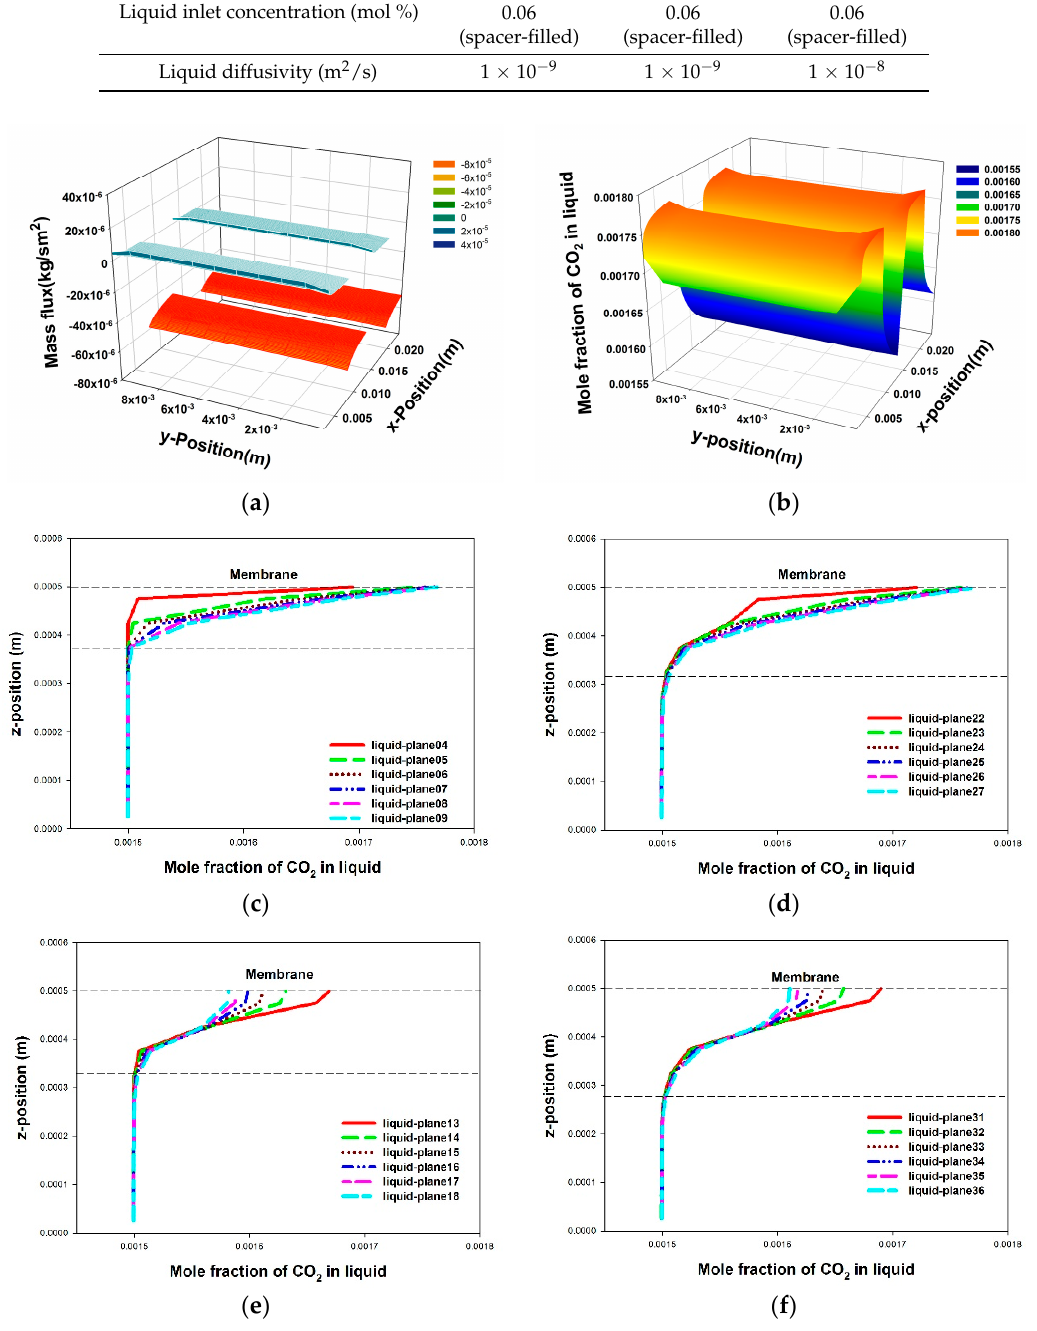
Figure 9. CE-HASMC BC internal profiles (( a ) transmembrane CO 2 mass flux, ( b ) membrane surface liquid CO 2 concentration, ( c ) first absorber (liquid entry: liquid-plane04), ( d ) second absorber (liquid entry: liquid-plane22), ( e ) first stripper (liquid entry: liquid-plane13), ( f ) second stripper (liquid entry: liquid-plane31), ( c – f ) CO 2 concentration profiles in liquid channel).